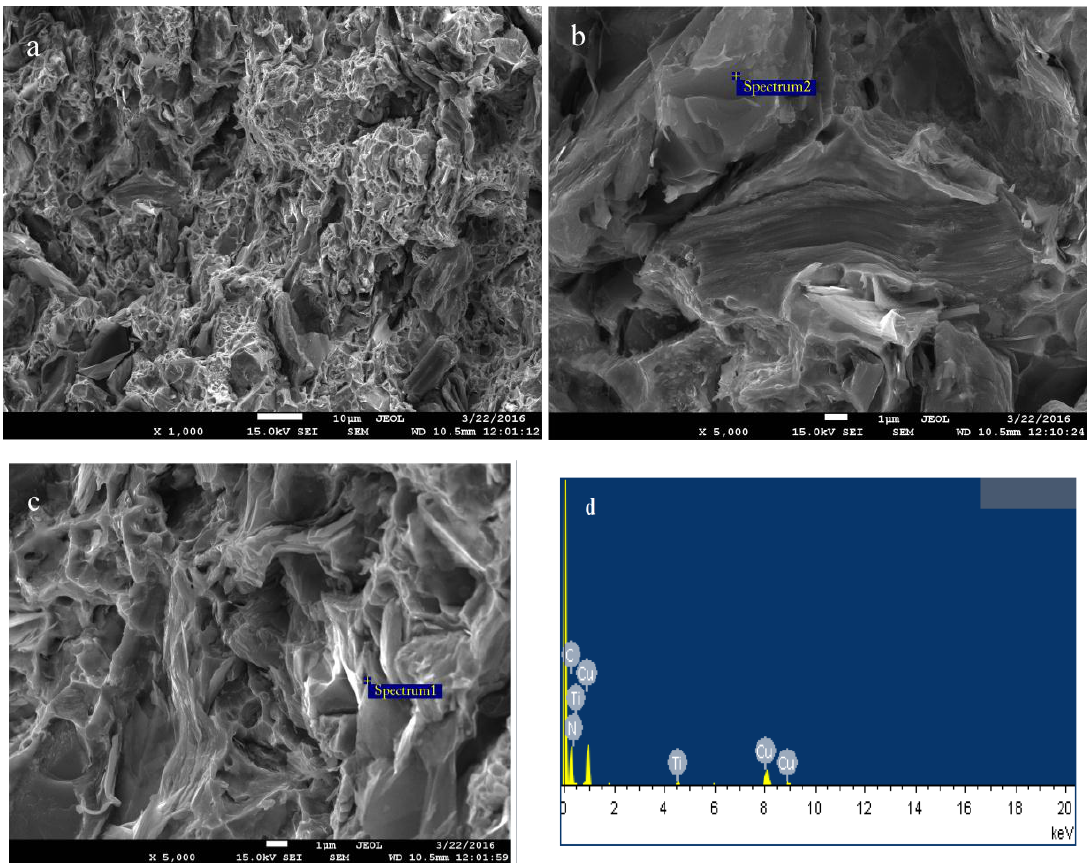
Figure 7. ( a – c ) SEM images of tensile fractures of the nanocomposites; ( d ) EDS element analysis of the marked lamellar spots in ( c ).